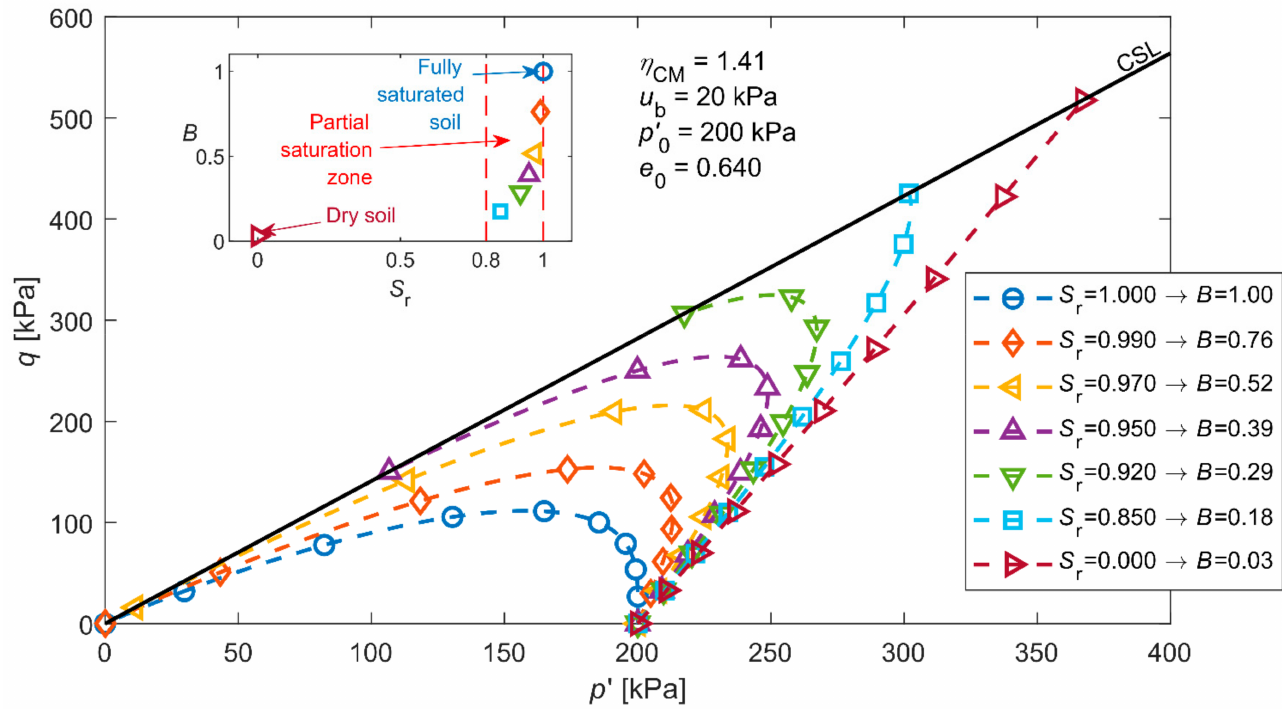
Figure 18. Theoretical prediction of stress paths for different saturations levels for OZM50 tailings.